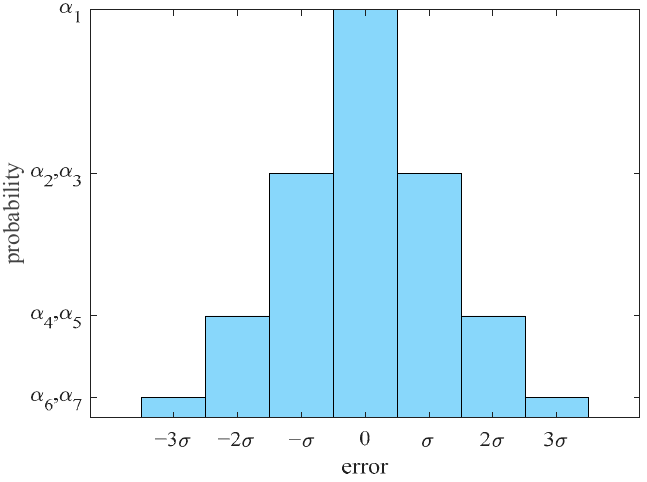
Figure 1. Load error probability density.